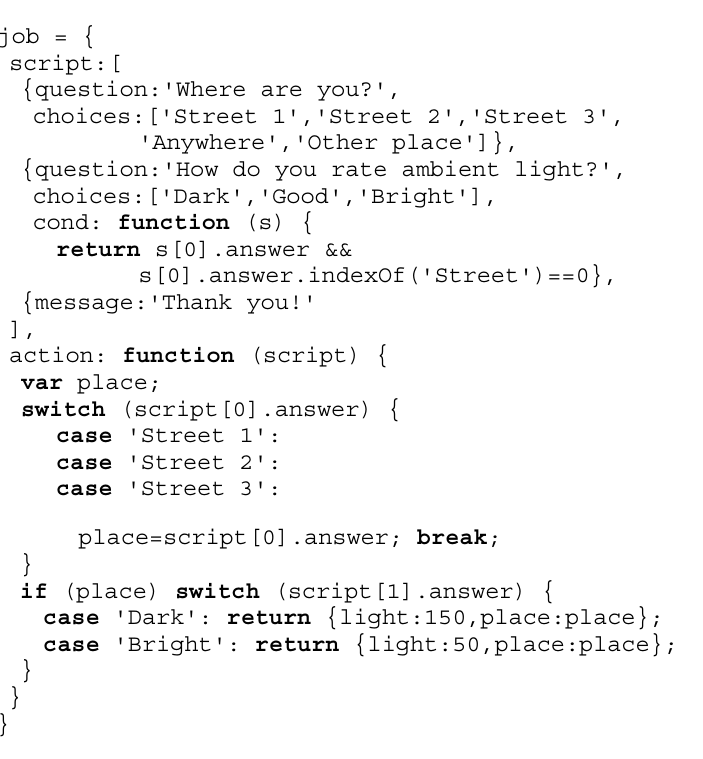
Figure 12. A demonstrator: An artificial street area consisting of street segments (blue rectangle), buildings (red rectangles), and beacons (yellow triangles), populated with stationary and mobile devices (green squares). The grey circles around beacons and nodes show the wireless communication range. Only overlapping circles connect